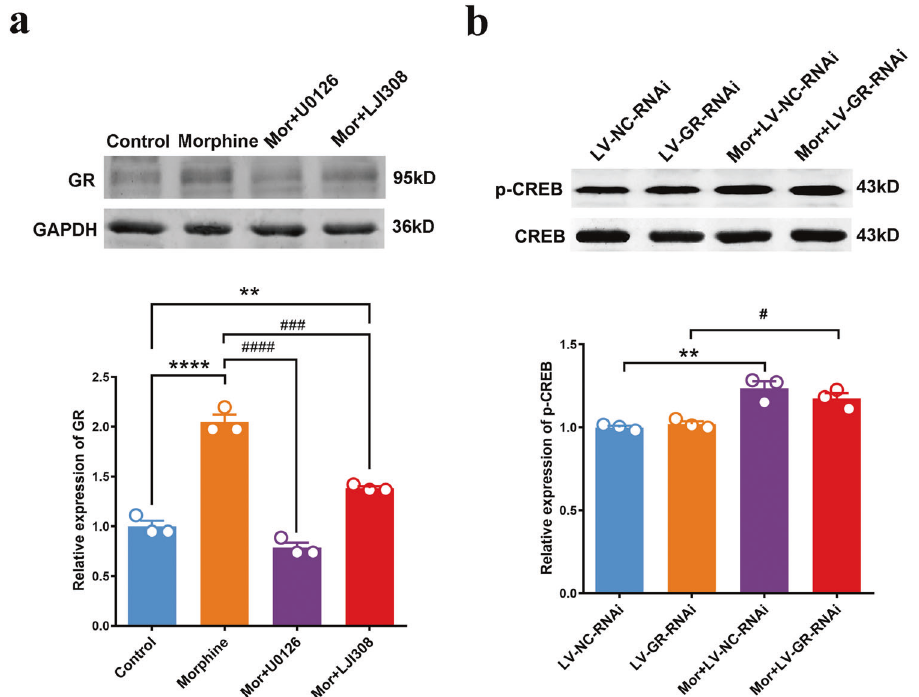
Fig. 4 The role of ERK-p90RSK-CREB signaling pathway in GR expression increase induced by chronic morphine treatment in primary cultured neurons. a The levels of GR protein expression in primary cultured mPFC neurons of each group ( n = 3 in each group, one-way ANOVA, F (3,8) = 107.7, P = 0.000, Bonferroni post hoc: ** P = 0.031, Morphine group vs Control group ## P = 0.000, Mor + U0126 group and Mor + LJI308 group vs Morphine group). b The level of p-CREB in primary cultured mPFC neurons of each group ( n = 3 in each group, one-way ANOVA, F (3,8) = 16.37, P = 0.009, Bonferroni post hoc: ** P = 0.002, Mor + LV-NC-RNAi group vs LV-NC-RNAi group; # P = 0.032, Mor + LV-GR-RNAi group vs LV-GR-RNAi group; P = 0.097, Mor + LV-NC-RNAi group and Mor + LV-GR-RNAi group). Data are presented as mean ±